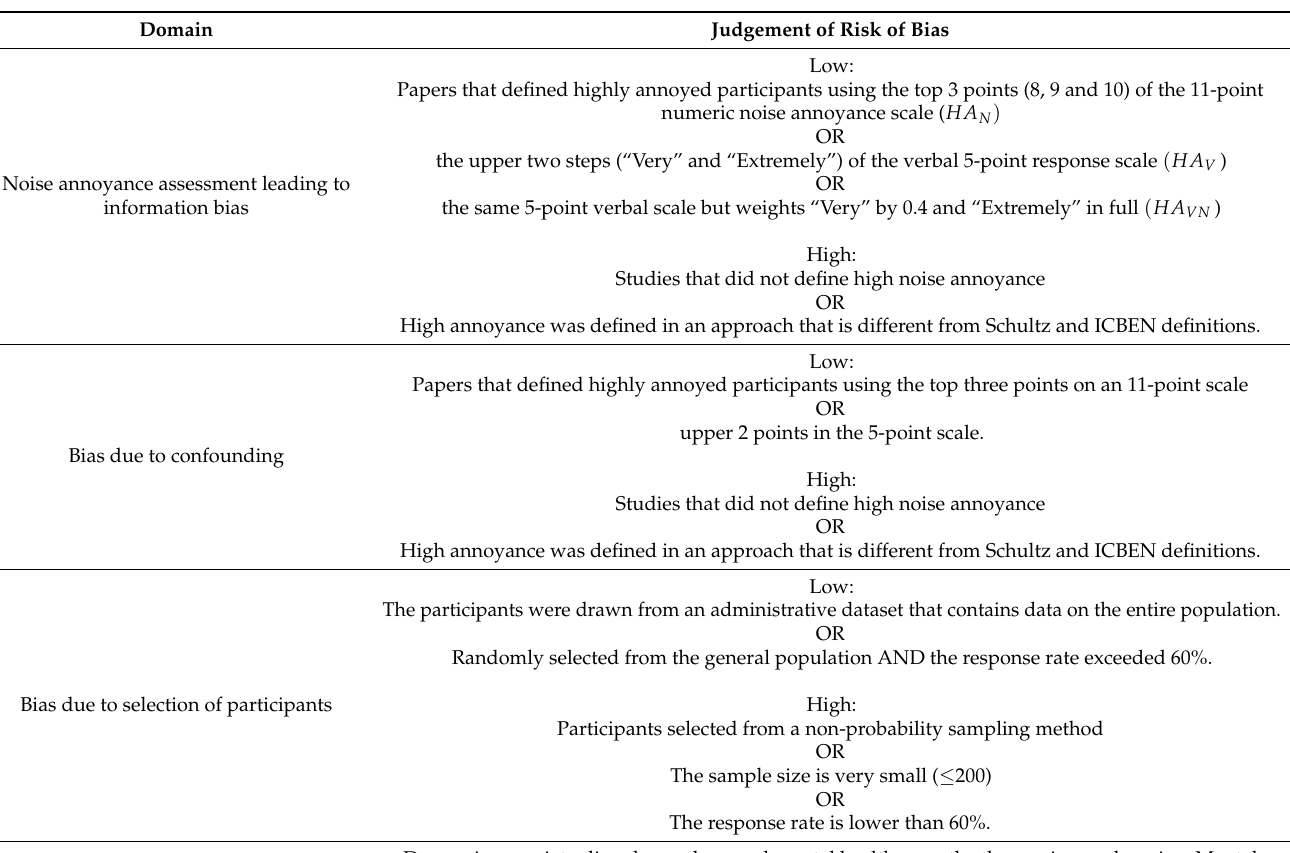
Table A3. Risk of bias assessment used for the systematic reviews underpinning the WHO Noise Guidelines for the European Region